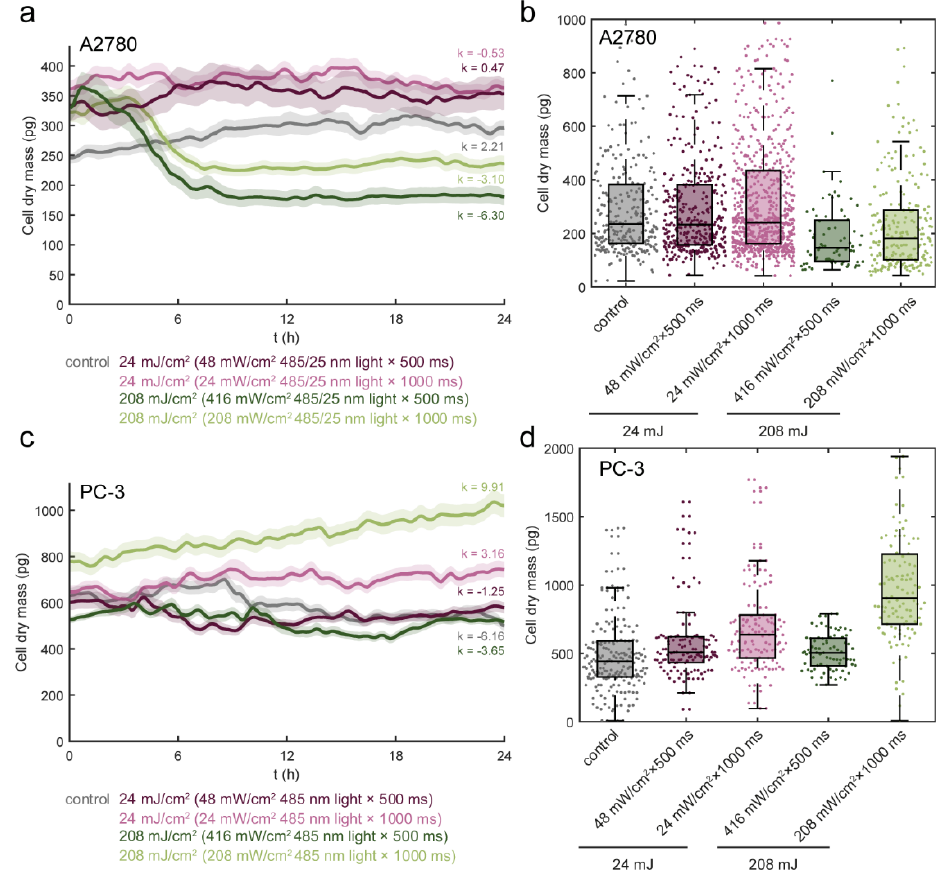
Figure 5. Real-time QPI-measured dry mass of cells affected by different doses of blue light. ( a ) Real-time changes in dry mass of A2780 cells during 24 h of the experiment. ( b ) The end-point dry mass values of A2780 cells after 24 h-exposure to blue light. ( c ) Real-time changes in dry mass of PC-3 cells during 24 h of the experiment. ( d ) The end-point dry mass values of PC-3 cells after 24 h-exposure to blue light. Bar charts are shown as the mean and standard error. Lines are shown as the mean and standard error. K value means the slope of the least-square fitted line (increment of the value per hour). Boxes are composed of the main box edges (25th and 75th percentile), central line (median) and whiskers (lowest and highest value of 1.5 of inter-quartile range).